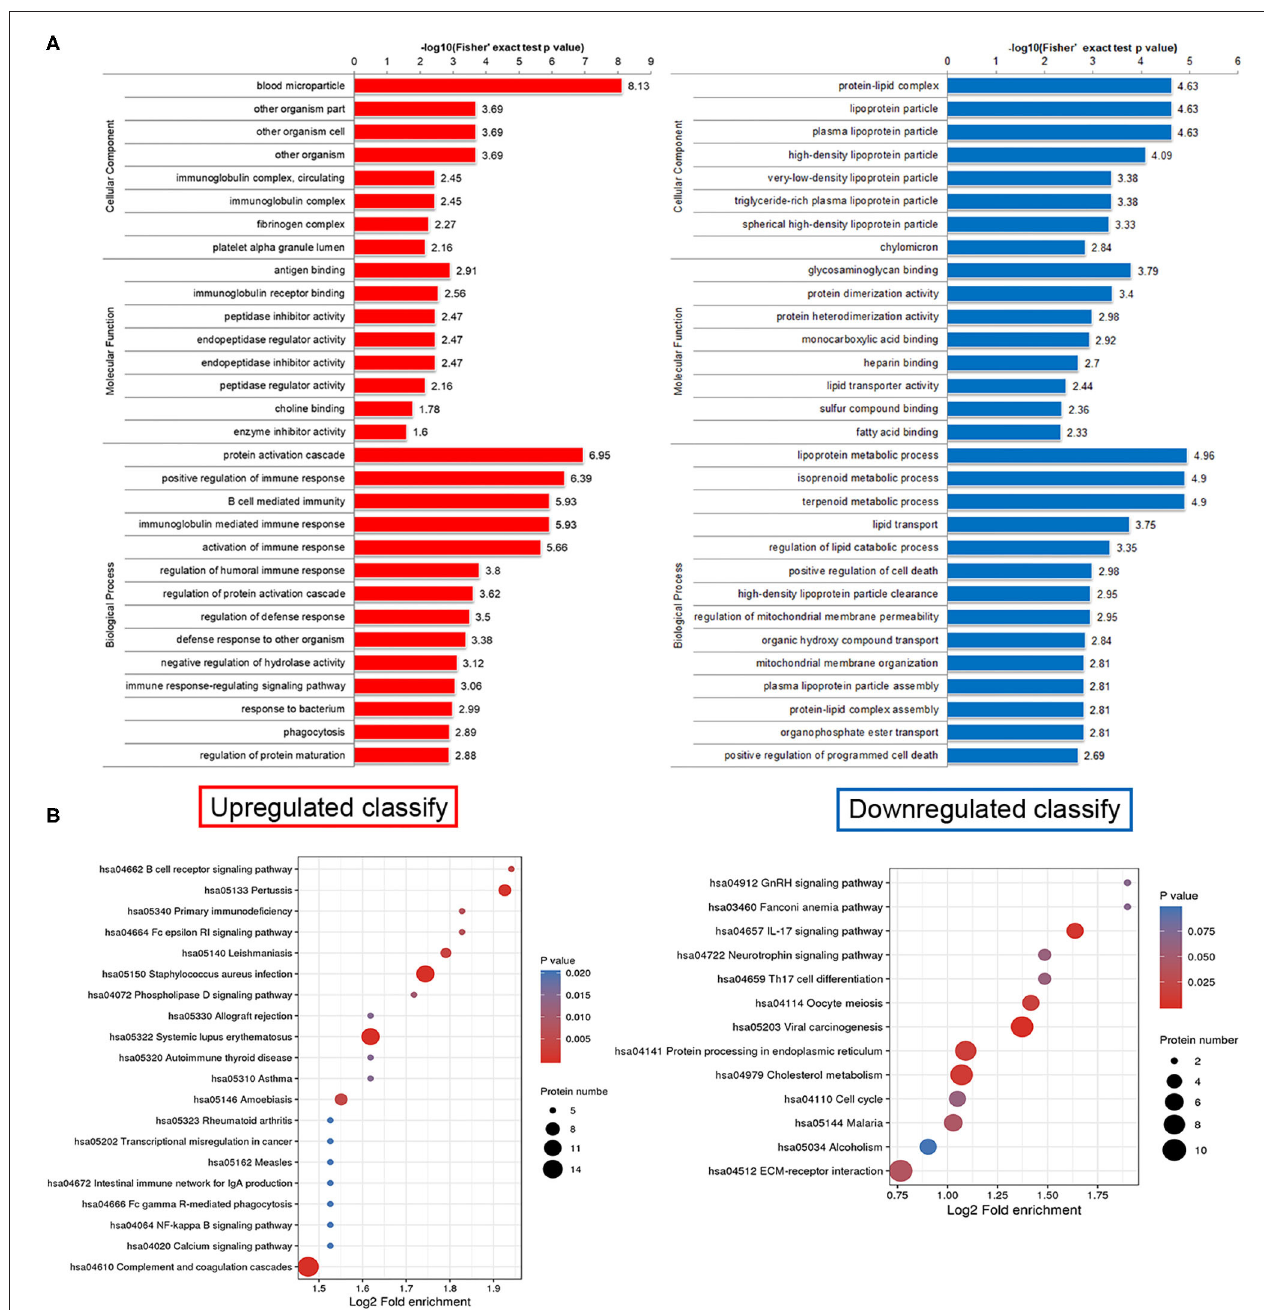
FIGURE 3 | Functional enrichment analysis of differentially expressed proteins in human plasma delivered exosomes. (A) Enrichment analysis on both GO classification and KEGG pathway in each comparison group. (B) The hot map of KEGG pathway enrichment analysis. Left side, Upregulated clarify; Right side, Downregulated